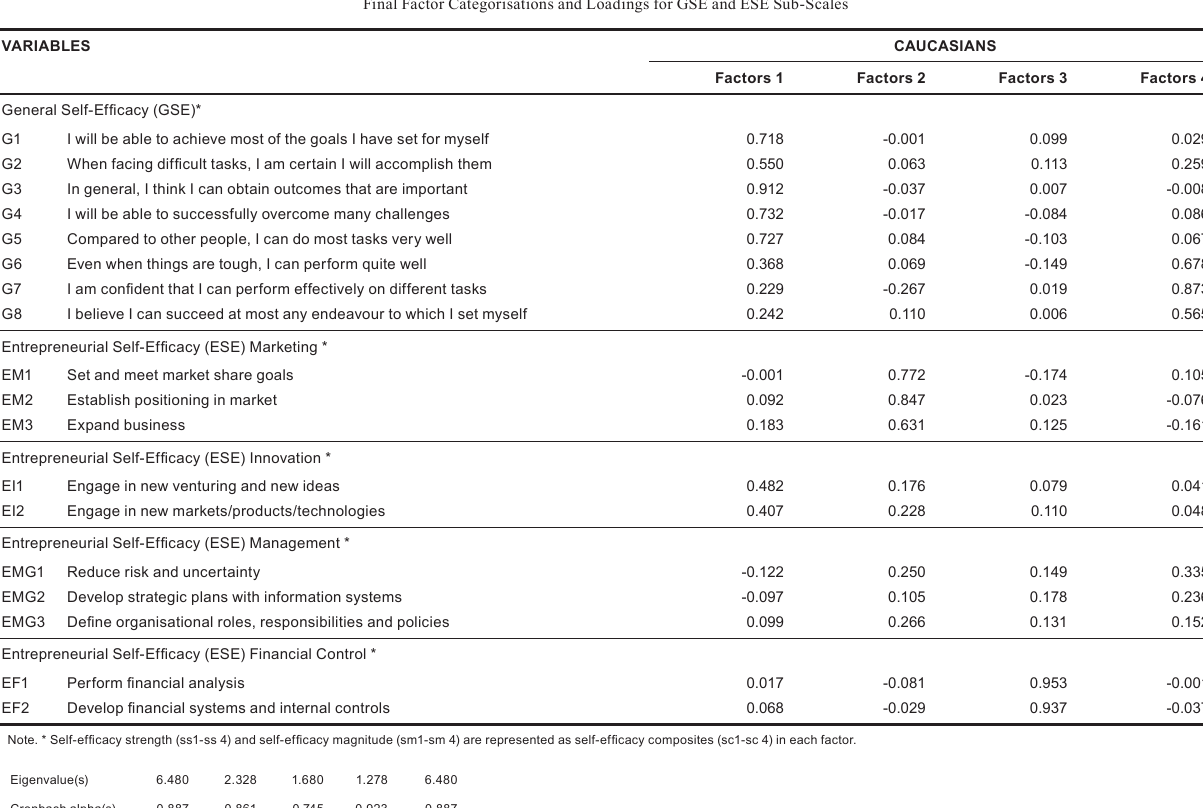
Table 2b Final Factor Categorisations and Loadings for GSE and ESE